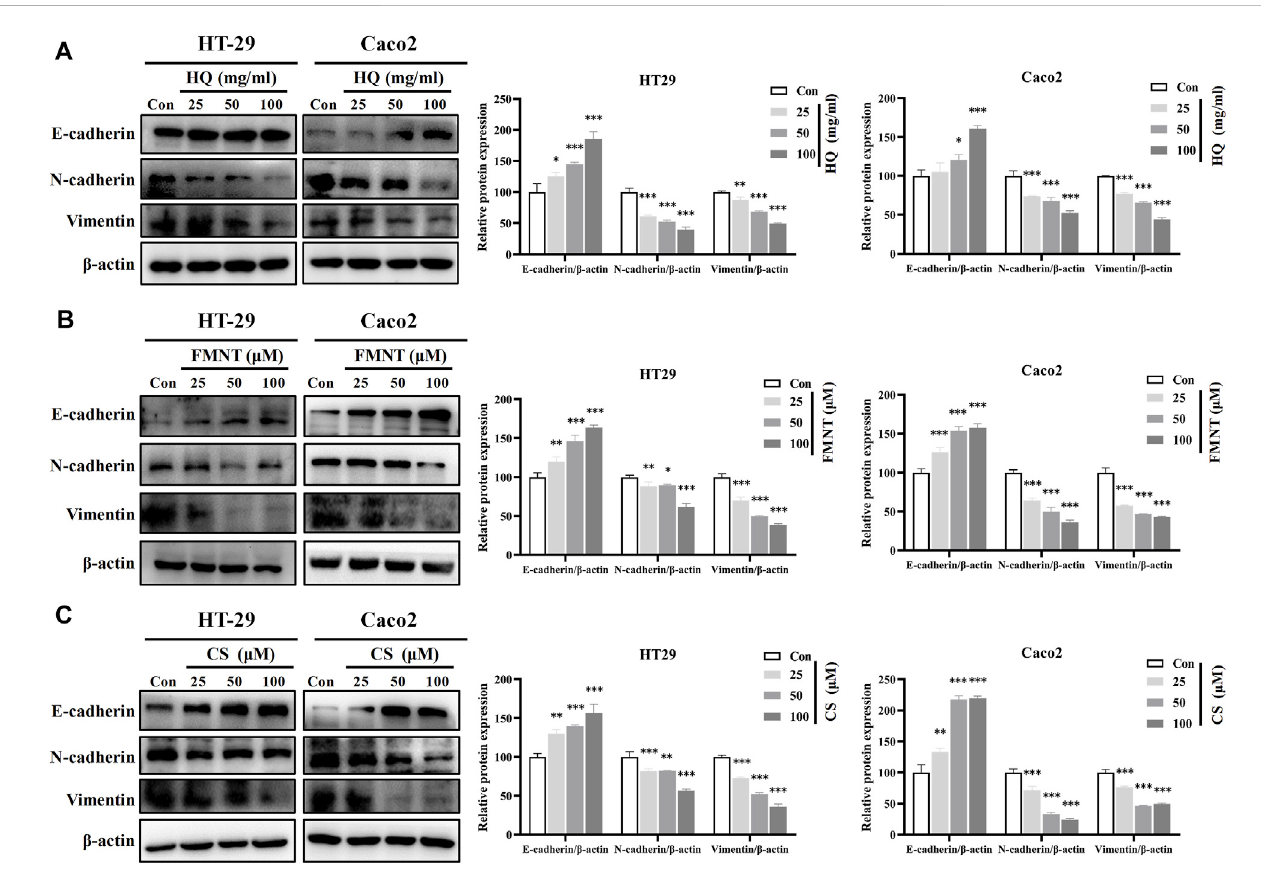
FIGURE 9 HQ, FMNT and CS signi fi cantly upregulated E-cadherin protein levels, and downregulated N-cadherin and Vimentin protein levels in HT29 and Caco2 cells. The protein levels of E-cadherin, N-cadherin, and Vimentin in HT29 and Caco2 cells were detected after treatment with HQ (25, 50 and 100 mg/mL, 48 h) (A) ,FMNT(25,50and100 μ M,48 h) (B) orCS(25,50and100 μ M,48 h) (C) ,respectively.Thedatarepresentthemean±SD( n =3).** p < 0.01and*** p < 0.001 compared with the control